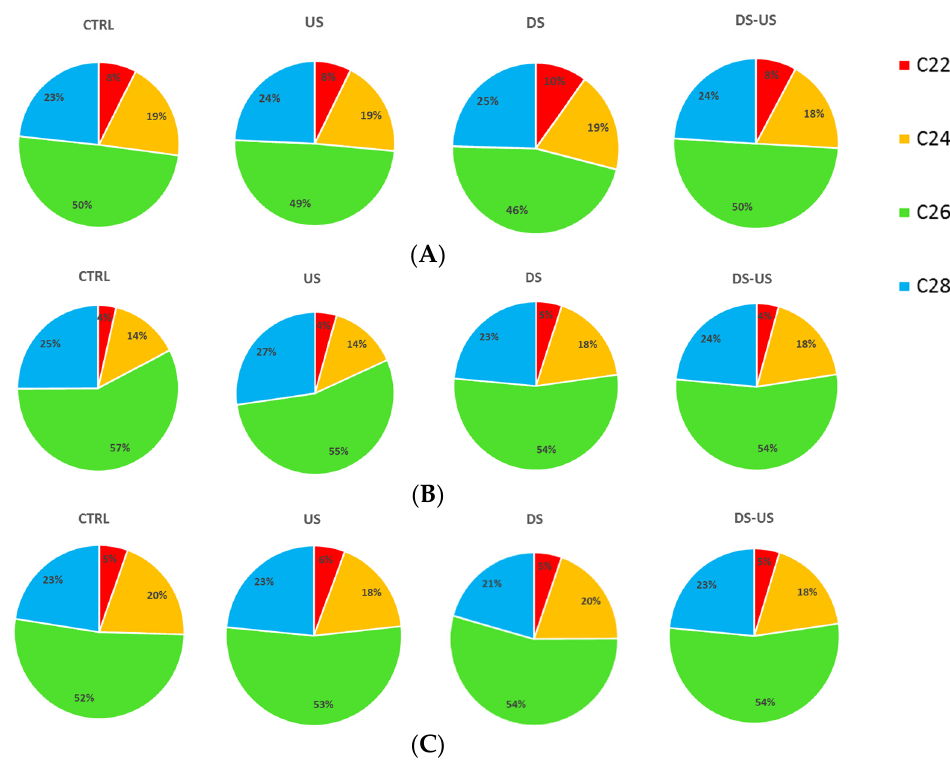
Figure 4. Total aliphatic alcohols (mg/kg), i.e., 1-docosanol (C22), 1-tetracosanol (C24), 1-hexacosanol (C26) and 1-octacosanol (C28), of Peranzana ( A ), Canino ( B ) and Coratina ( C ) EVOOs, treated by the different processes (CTRL = control test, US = ultrasound test, DS = destoned test, DS-US = destoned-ultrasound test).